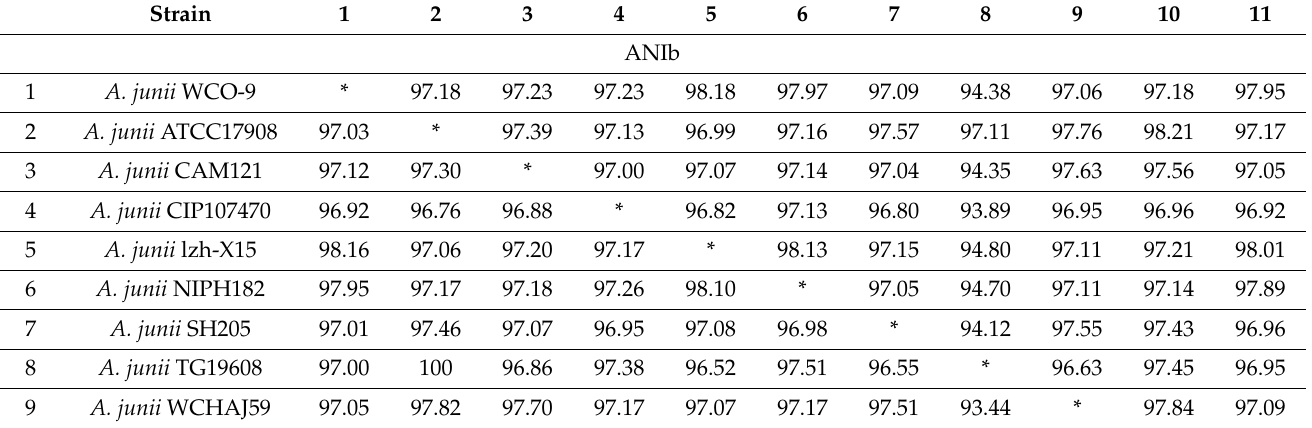
Table 3. ANIb, ANIm and DDH values of strain WCO-9 and 10 strains of the same